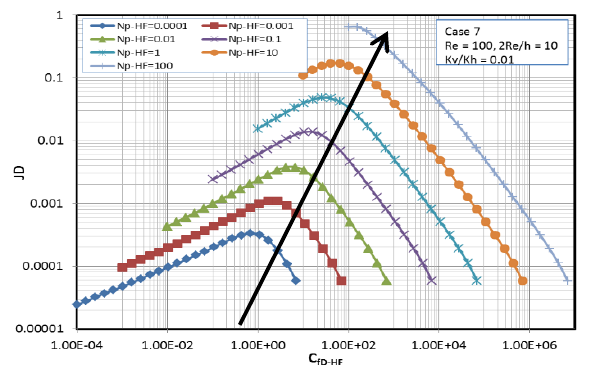
Figure 4—Case 7 with k